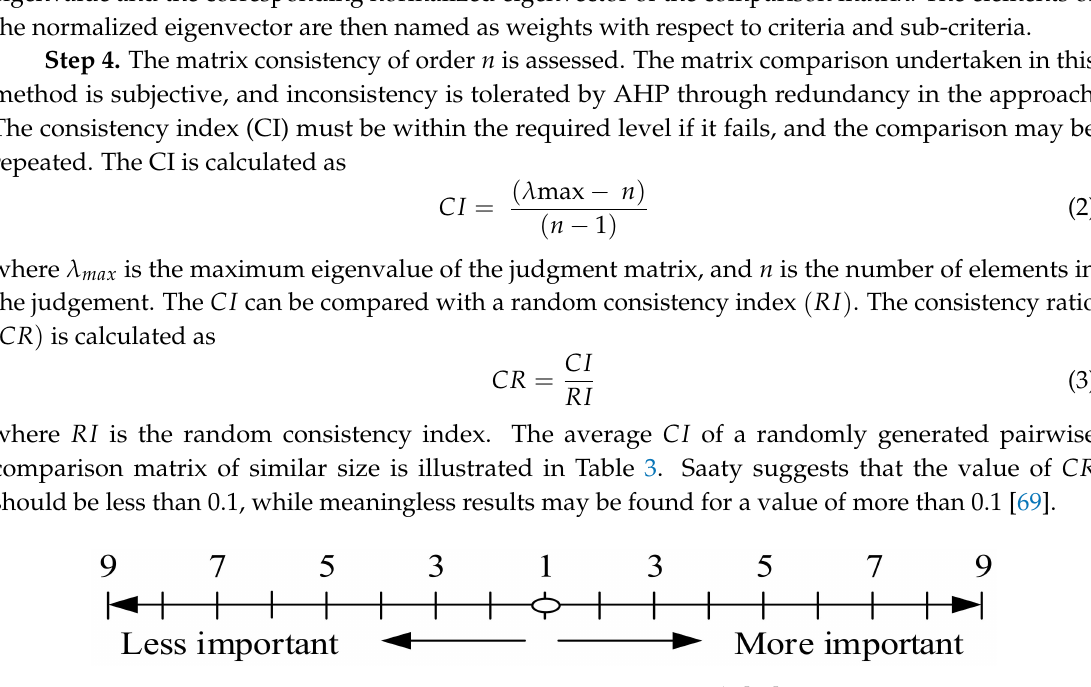
Figure 7. Pair-wise comparison matrix scale [70]. Table 3. Random index (RI) scale